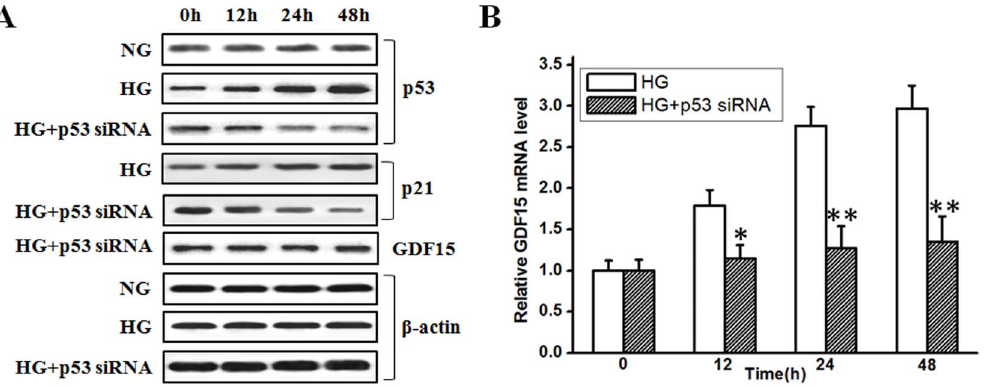
Figure 3. Knockdown of p53 expression inhibited high glucose-induced GDF15 expression. p53 siRNA was transfected into HUVEC cells. 12 h after transfection, HUVEC cells were treated with high glucose (33.3 mmol/l). A, at indicated time points, p53, p21, GDF15, and b -actin proteins were detected by western blot. B, GDF15 mRNA was detected by RT-PCR. NG, normal glucose. HG, high glucose. *, P , 0.05, **, P , 0.01 versus HG.